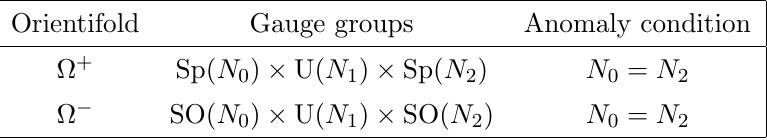
Table 5. The unoriented C = Z 0